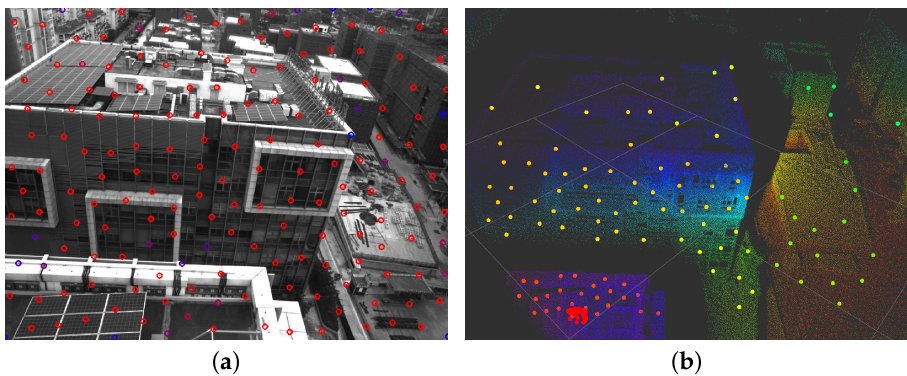
Figure 3. ( a ) The visual features on the image. ( b ) The estimated 3D points of visual feature. It’s clear that lots of visual features can get accurate estimates of their 3D points.